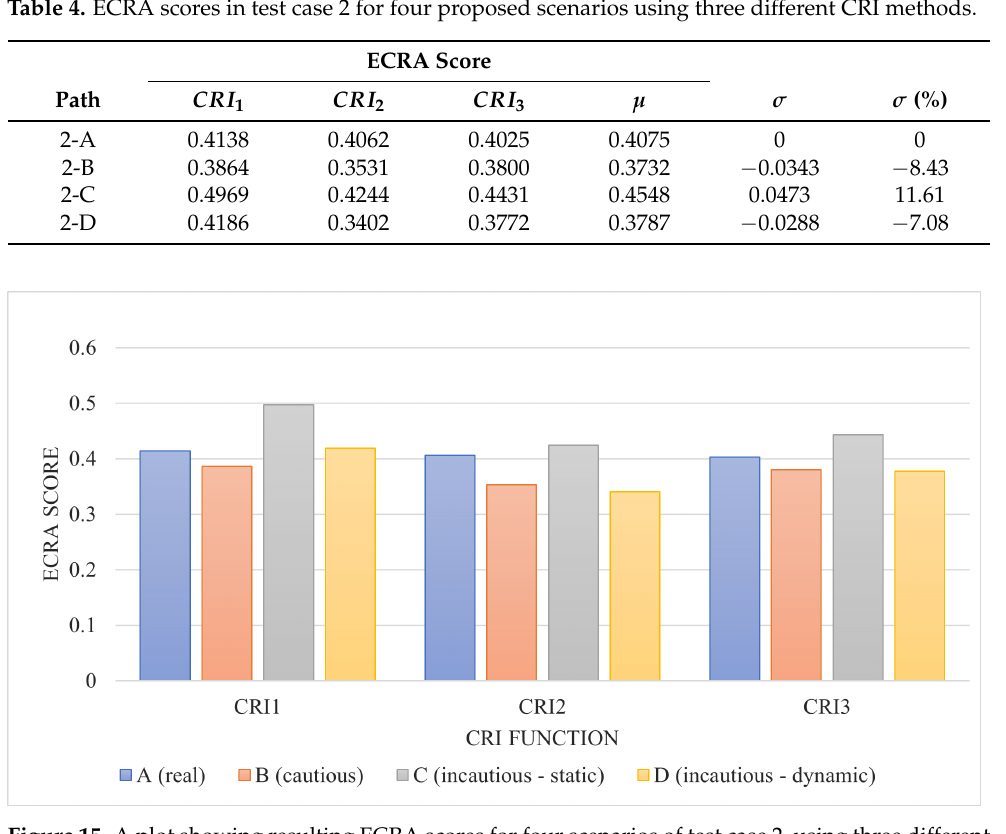
Figure 15. A plot showing resulting ECRA scores for four scenarios of test case 2, using three different CRI